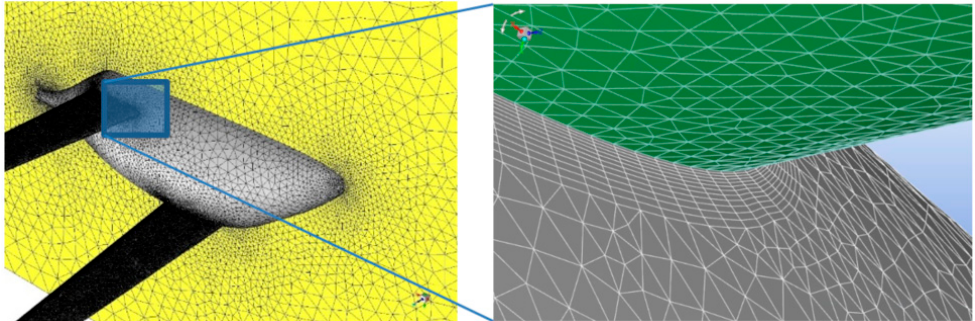
Figure 3. Fragments of the computational domain and local mesh.